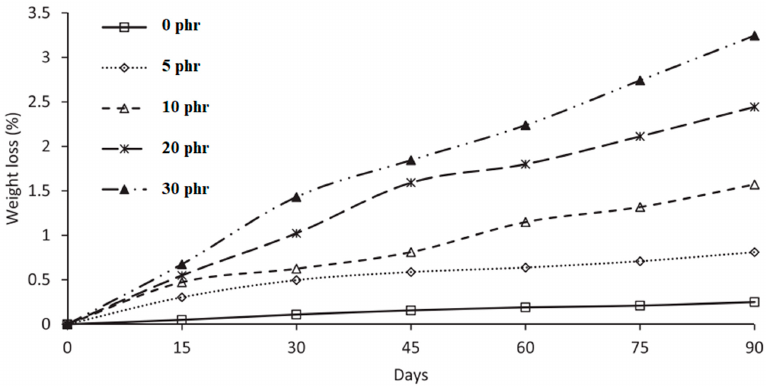
Figure 1. Weight loss of sisal fiber/NR composites with different filler contents (adapted with per- mission from [19]).